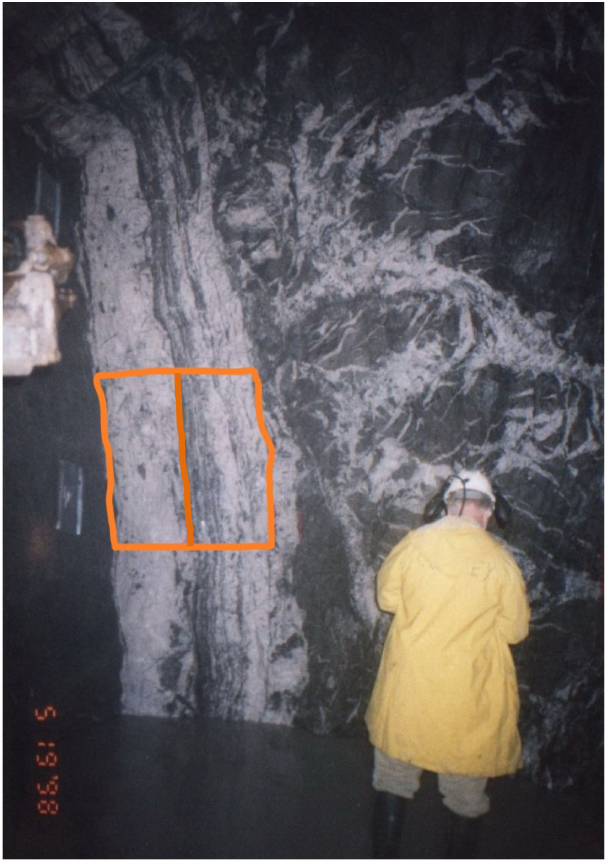
Figure 18. Panel sample outlined area on LV (highlighted in orange). In this case, the composite LV is 1.2 m wide and should be collected as 0.5 m (massive LV) and 0.7 m (strong LV) wide